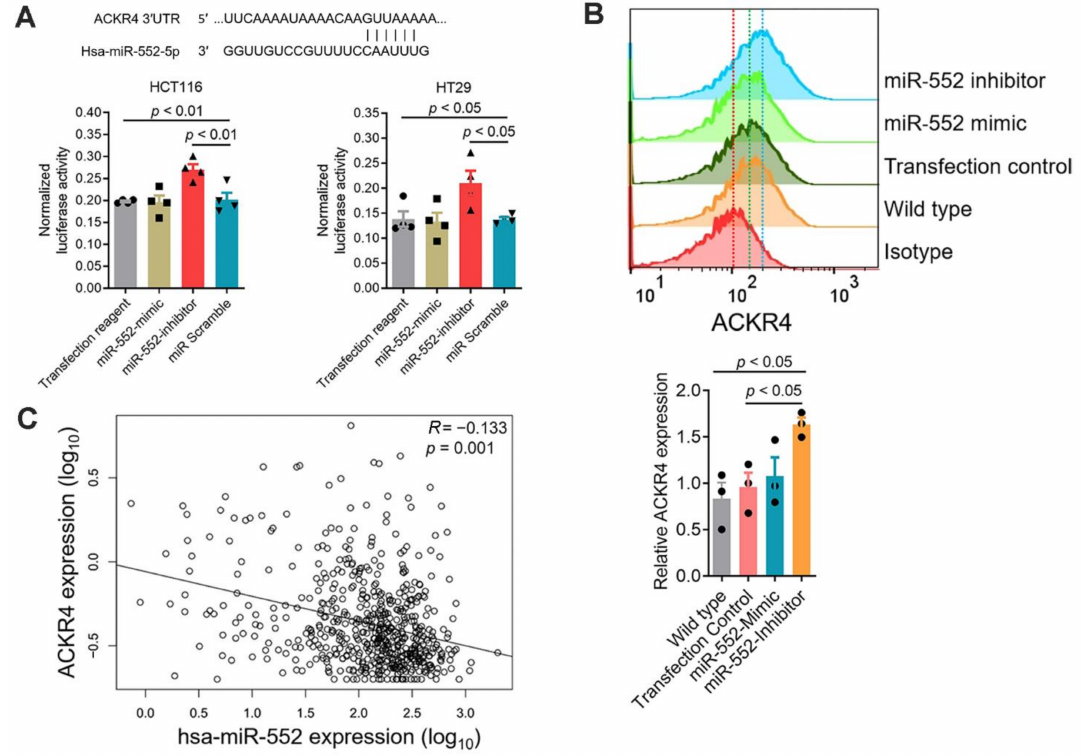
Figure 6. miR-552 downregulates ACKR4 expression in CRC tumors. ( A ) The sequence match between the miR-552 and the ACKR4 3 (cid:48) -untranslated region (UTR). Dual-luciferase assay confirmed that miR-552 binds to the 3 (cid:48) -UTR of ACKR4 ( n = 4). ( B ) miR-552 inhibitors enhanced ACKR4 expression in HCT116 cells ( n = 3, the red vertical dot line indicates the isotype group’s mean signal intensity, the green dot line indicates the transfection control group’s mean signal intensity, and the blue vertical dot line indicates the miR-552 inhibitor group’s mean signal intensity). ( C ) A negative correlation between ACKR4 and miR-552 in the TCGA colorectal cancer dataset (The black line is the regression line). (For more than two group statistical analyses, the uppermost p -value indicates the ANOVA-analysis, and other p -values indicate the posthoc analysis between two specific groups. miR: MicroRNA, Hsa: Homo sapiens, TCGA: The Cancer Genome Atlas, ANOVA: Analysis of